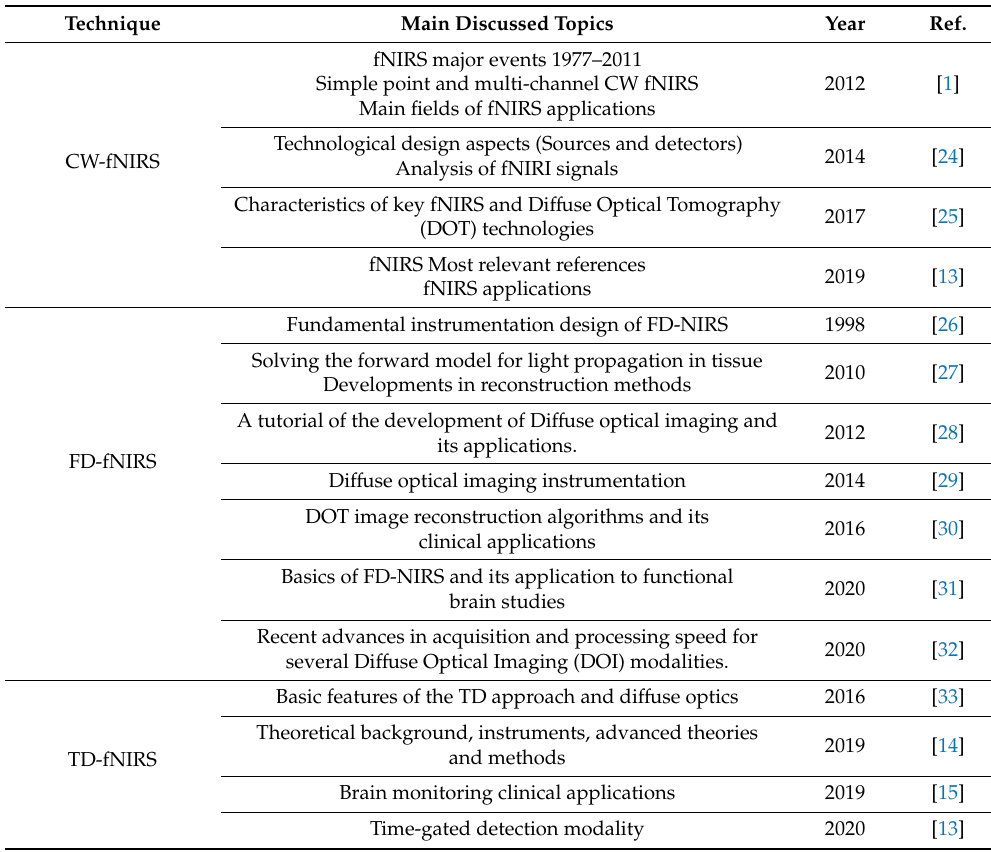
Table 1. Most relevant review papers about CW-, FD-, and TD-fNIRS